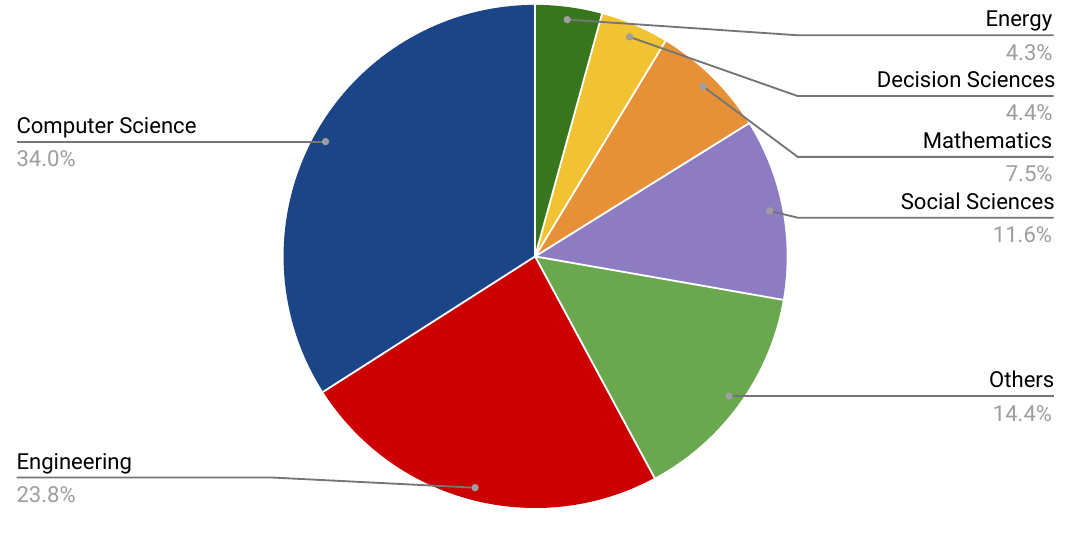
Figure 2. The rise of the interest in SCs’ transportation systems by different field of knowledge (search was done on June 20th, 2019 on the Scopus